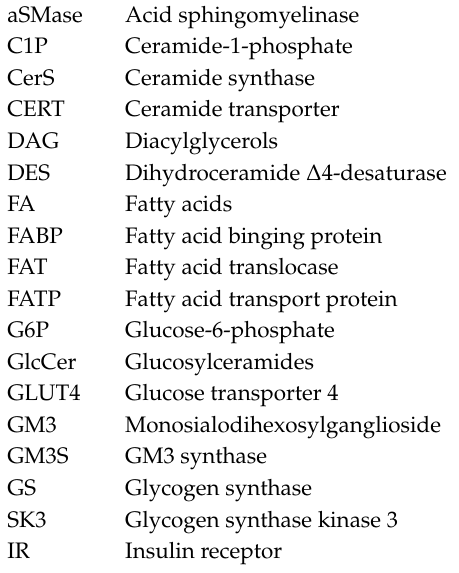
Figure preparation: C.L.B. Critically reviewed the manuscript and figures: C.L.B., S.T.-C., O.B., H.L.S., and E.H. All authors approved the final